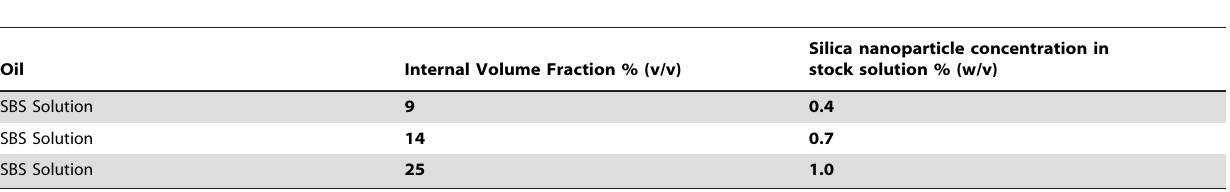
Table 1. Compositions of the emulsions prepared to investigate the effects on the properties of emulsion templates. a